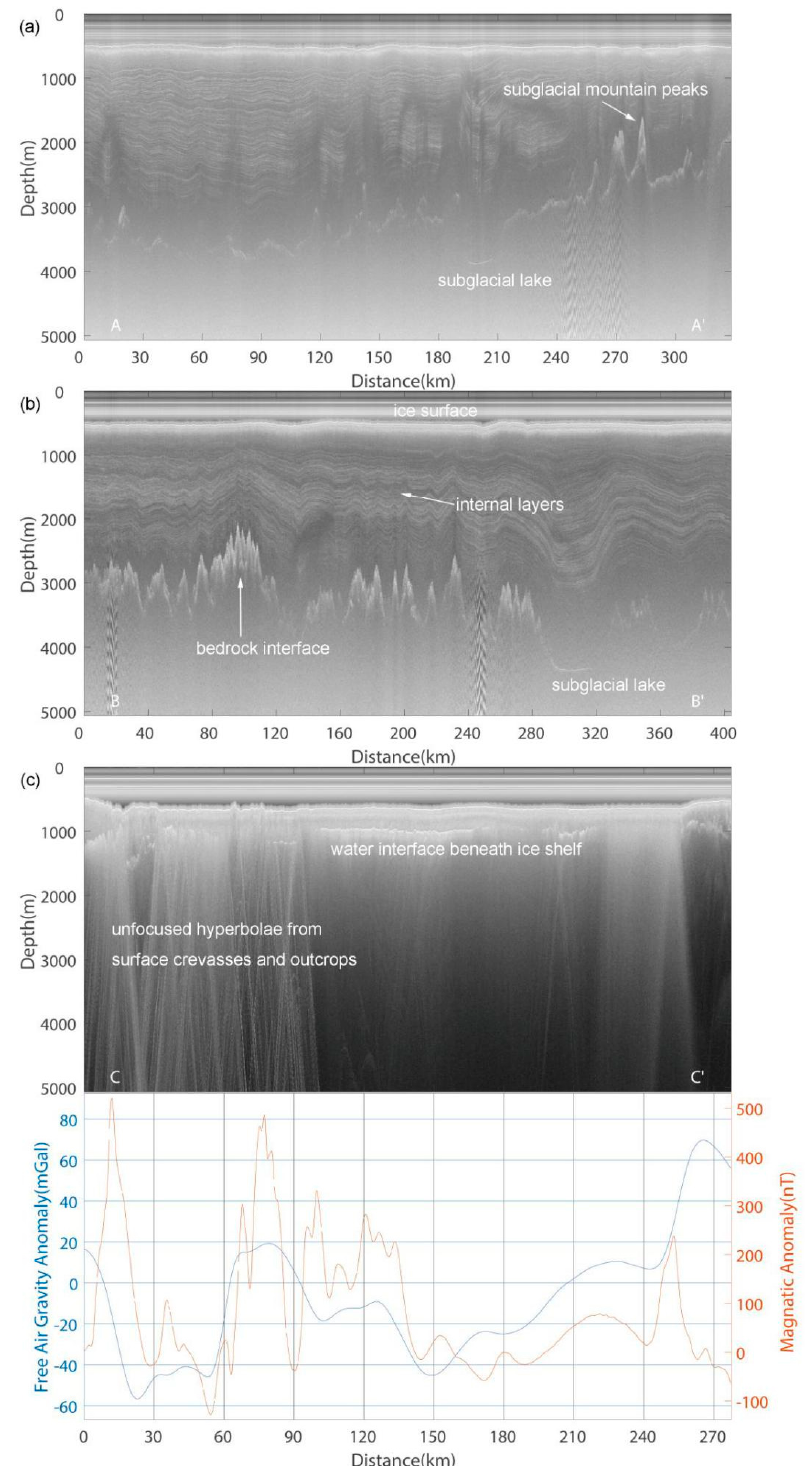
Figure 6. Data profiles along project/set/transects (PSTs) in Princess Elizabeth Land (PEL), Ridge B and the Amery Ice Shelf, respectively. ( a ) Radargram along LSE/GCX0e/Y87a, LSE = Lake of Snow Eagle; ( b ) radargram along TSH/GCX0g/R41a; ( c ) radargram, free air gravity anomaly and magnetic anomaly along AMY/GCX0e/Y184a, AMY = Amery.